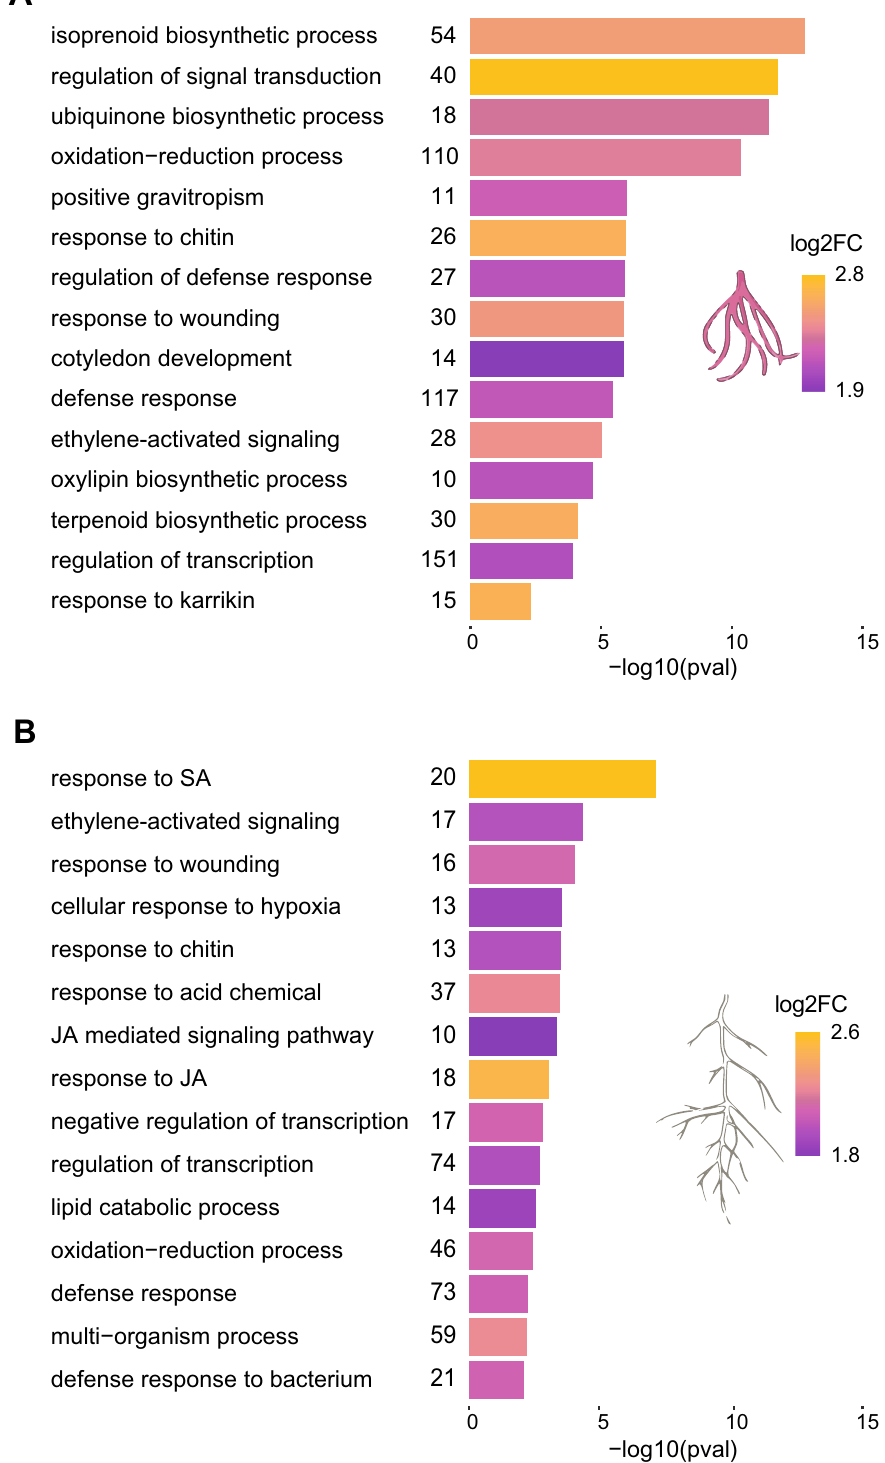
Figure 5. Gene ontology (GO) enrichment analysis of biological processes upregulated in response to MeJA, and SA as compared to control in Lithospermum officinale . Functional enrichment of ( A ) MeJA- and ( B ) SA-induced genes. Length of horizontal bars depict the degree of significance of GO terms as estimated by Fisher’s exact test. GO terms with p -value < 0.01 were considered overrepresented. Numbers right to the horizontal bars reflect the number of differentially expressed genes in the respective GO term. The heatmap is computed from average log2fold changes to reflect the expression of genes in the corresponding GO category. Only the top 15 (based on p -value) GO terms are shown here. A complete list of significant GO terms is presented in Supplementary Tables